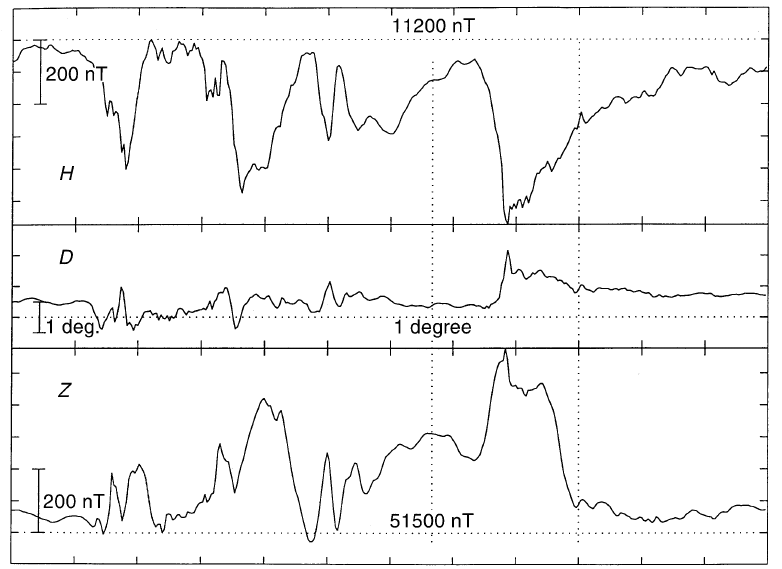
Fig. 2. The magnetogram recorded at Troms (cid:249) Auroral Observatory on 7 March 1991. Negative H indicates a westward electrojet. Positive Z indicates that the electrojet is to the south of Troms (cid:249) . The dotted lines span the interval (21 (cid:50)(cid:48) — 22 (cid:51)(cid:48) UT) covered by the EISCAT and magnetometer data given in Figs. 7, 8 and 6,